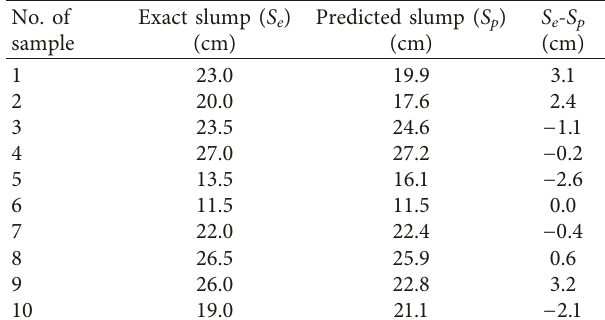
Table 10: Comparison of exact slump with SPNN-predicted slump for the 10 testing samples.